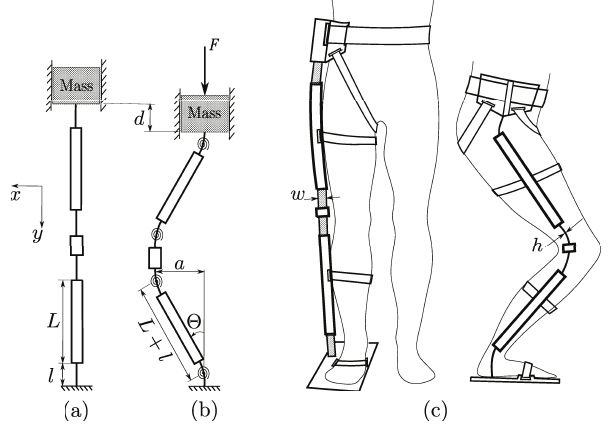
Figure 1. (a) Schematic diagram of a constant-force mechanism and a mass to be balanced, (b) the corresponding pseudo-rigid-body model (PRBM), and (c) an implementation example for humanoid robot.